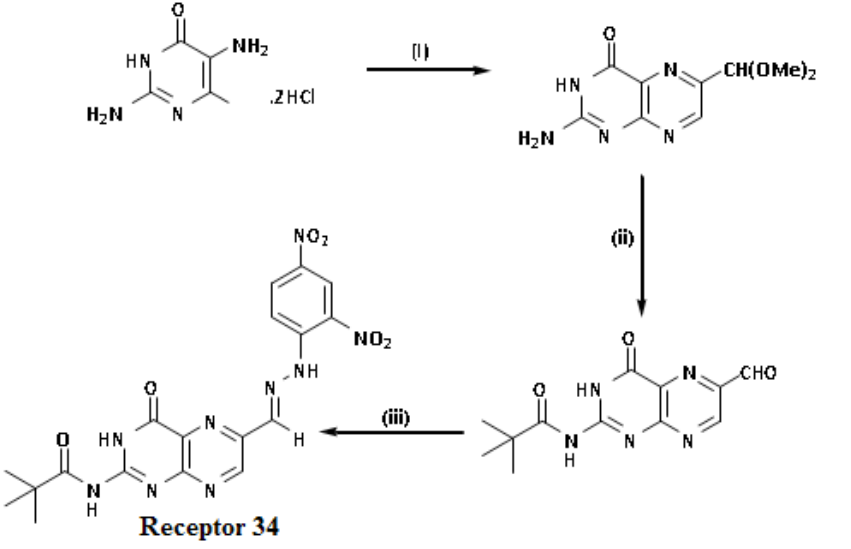
Figure 22: UV-vis absorption spectra of R 34 (C= 1x 10 -5 M) upon titration with TBAA (tetrabutylammonium acetate) (C= 2x 10 -4 M) in CH 3 CN at 25 0 C. Inset: Non-linear 1:2 fitting isotherm recorded at 573 nm. (adapted from ref.71e).